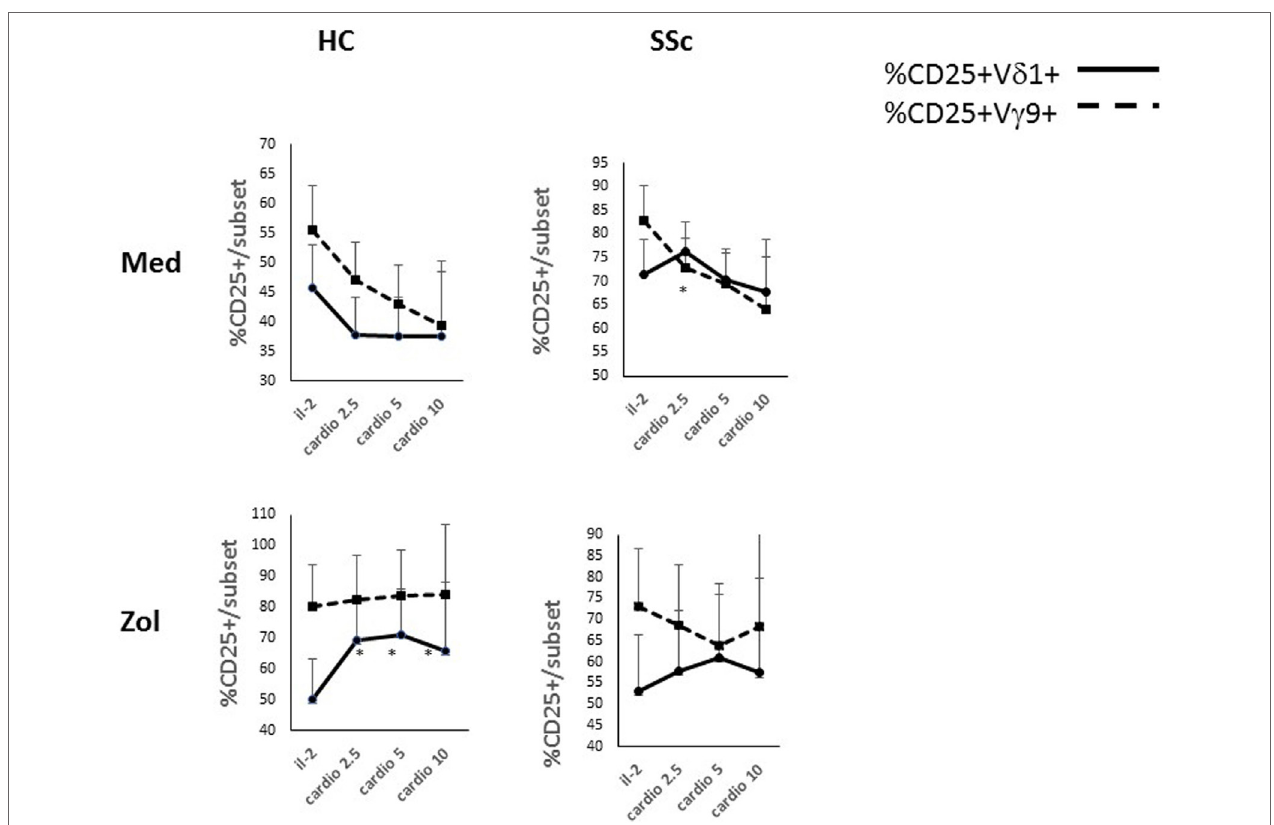
FigUre 3 | Dose effects of cardiolipin (CL) on cultured T cells in the presence and absence of zoledronate (zol). Dose response of % CD25 + V δ 1 + or V γ 9 + T cells as indicated (%CD25 + within a subset/total% of subset) after in vitro culture for 4 days in medium containing interleukin-2 (IL-2) 100 IU or, in addition, increasing concentration of CL (in microgram per milliliter) as indicated on the x -axis are shown. In parallel cultures, zol (2 µM) was added. Results represent mean and 1 SEM for cultures derived from three HCs and from five systemic sclerosis patients. Asterisks indicate a significant difference ( p < 0.05) for comparison of the mean at the relevant concentration of CL to IL-2